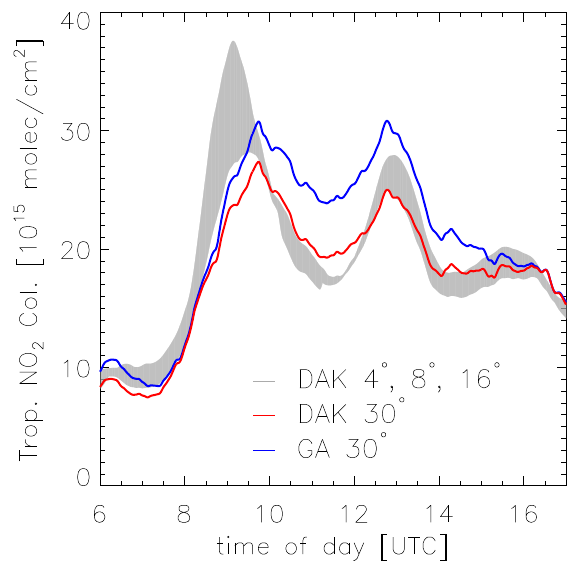
Fig. 13. Retrieved tropospheric NO 2 column in De Bilt for 21 March 2009. The grey band indicates the tropospheric NO 2 column retrieval with the two-step algorithm, based on differential slant column measurements at α = 4 ◦ , 8 ◦ and 16 ◦ . The red line represents the two step-algorithm applied to 30 ◦ . The blue line is based on the geometrical approximation (GA), also for 30 ◦ elevation. A one-hour running average has been applied to the differential slant column data in order to suppress noise.